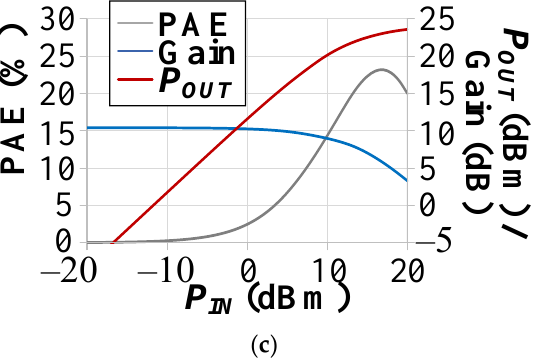
Figure 10. Large-signal EM PEX simulations of the broadband differential GaN PA for CW inputs at ( a ) 24, ( b ) 28, and ( c ) 44 GHz.